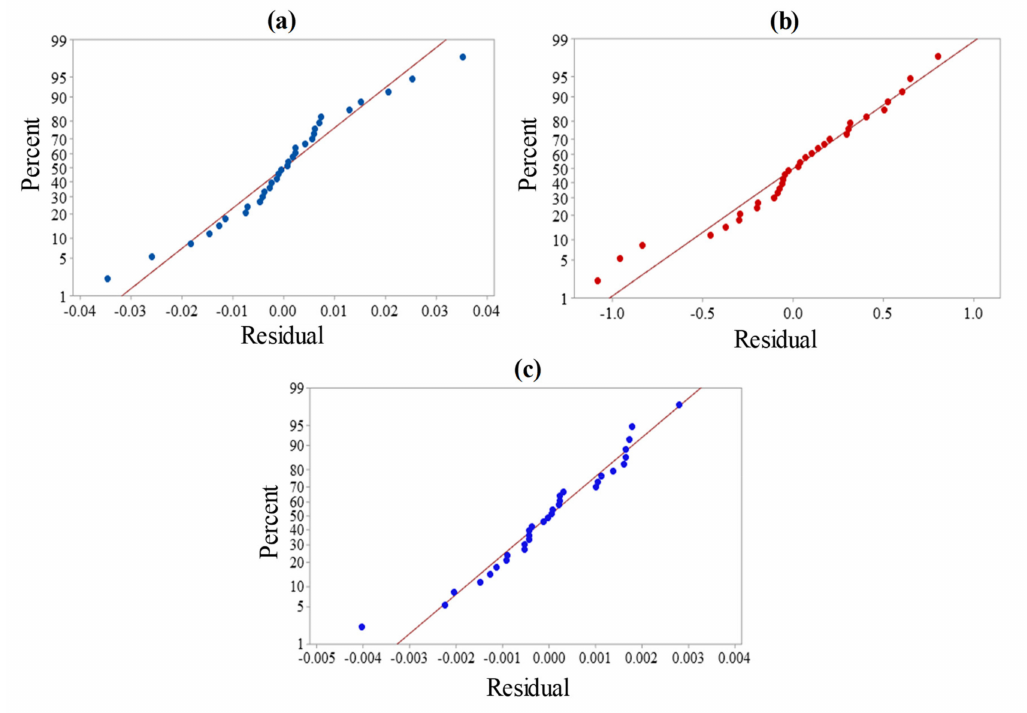
Figure 5. Normal probability plots for ( a ) Ra, ( b ) EC, and ( c )